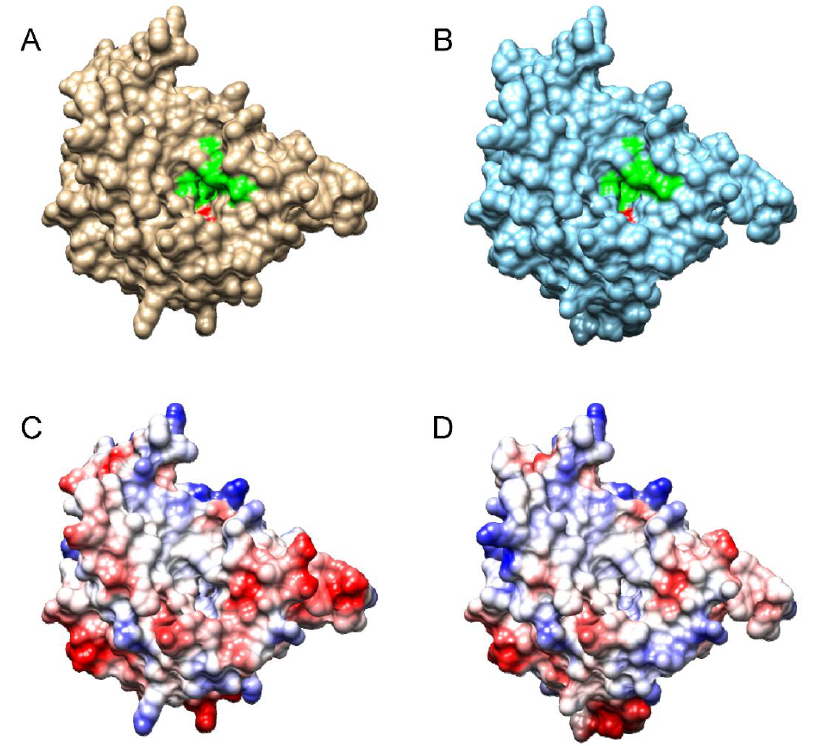
Figure 10. Proposed structural models for Arabidopsis LIP2p1 ( A , C ) and LIP2p2 ( B , D ) based on that of Mycobacterium tuberculosis octanoyl-ACP (acyl carrier protein) acyltransferase (1w66) [21]. Panels ( A , B ) are views of the molecular surfaces in which the residues involved in the active site are shown in green and the catalytic lysine residue in red. Panels ( C , D ), views of the molecular surfaces showing the electrostatic potentials according to Coulomb’s laws. Therefore, metabolic differences between the mutants lacking one of these enzymes are expected not only due to structural differences but also due to expression levels. The analysis of the results points to a greater effect on lipids species, although changes going in the same direction were observed, in the absence of LIP2p2 rather than when lacking LIP2p1 (Figures 1, 2, 4, 5 and 7), so we will use this mutant more pronouncedly to explain possible causes of observed phenotypes (lipid differences). Firstly, the reduction of this transferase activity, depending on its total contribution, would entail a greater availability of octanoyl-ACP for the synthesis of fatty acids, leading to expected higher synthesis of these compounds, as observed in lip2p2 seeds. In addition, competition with FAS complex enzymes, which could be being limited by this protein, would be reduced. The increase of the fatty acids per seed (Figure 1C) and the reduction of palmitic acid content (due to greater FAS activity, Figure 1A) would support the above statement. This would produce a greater synthesis of oleic as the end product of the intraplastidial fatty acid biosynthesis. The expected lack of alterations in the levels of expression/activity of the endoplasmic reticulum enzymes, which carry out subsequent modifications of oleic acid or the assembly of triacylglycerols, due to minor changes in fatty acids coming out from the plastid, together with its greater synthesis in octanoyltransferase mutants, causes a higher incorporation of oleic and a relative reduction of linolenic acid in seed triacylglycerols (Figure 1A). Meanwhile, in seedlings, the consequence is an increment of oleic, linoleic, and gondoic acid and a reduction of linolenic acid (Figure 2). The opposite effect, to the one observed in octanoyltransferase mutants (increase of 18:3 and reduction of 18:1 and 18:2 and 20:1), occurs when there is a reduction of the synthesis of fatty acids in mutants with lower levels of KASI [26] and KASIII activities [27], confirming/ratifying that the activity of